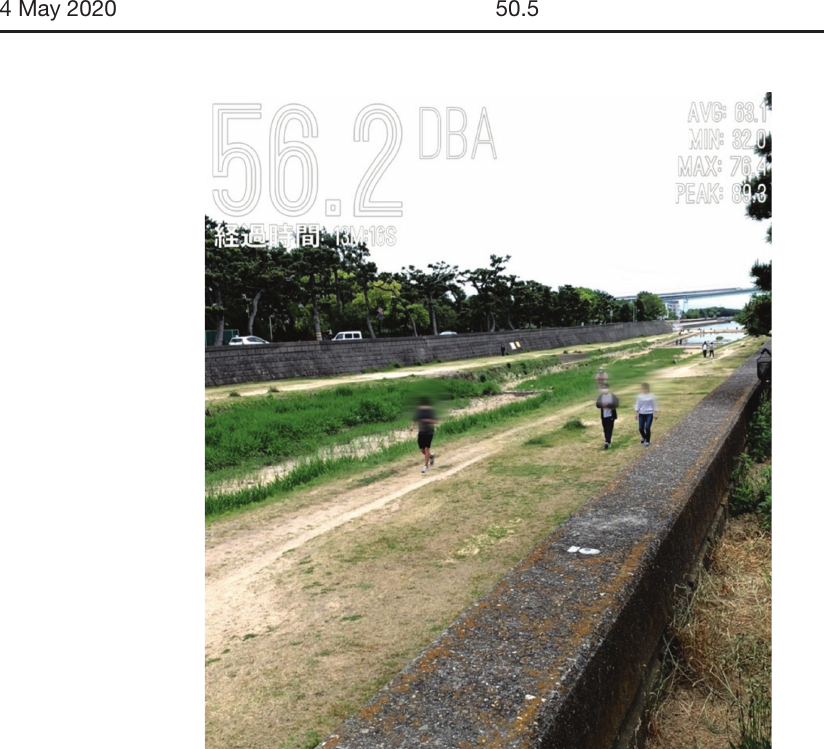
Table 2. Noise levels at the fixed point on the riverside, L Hour